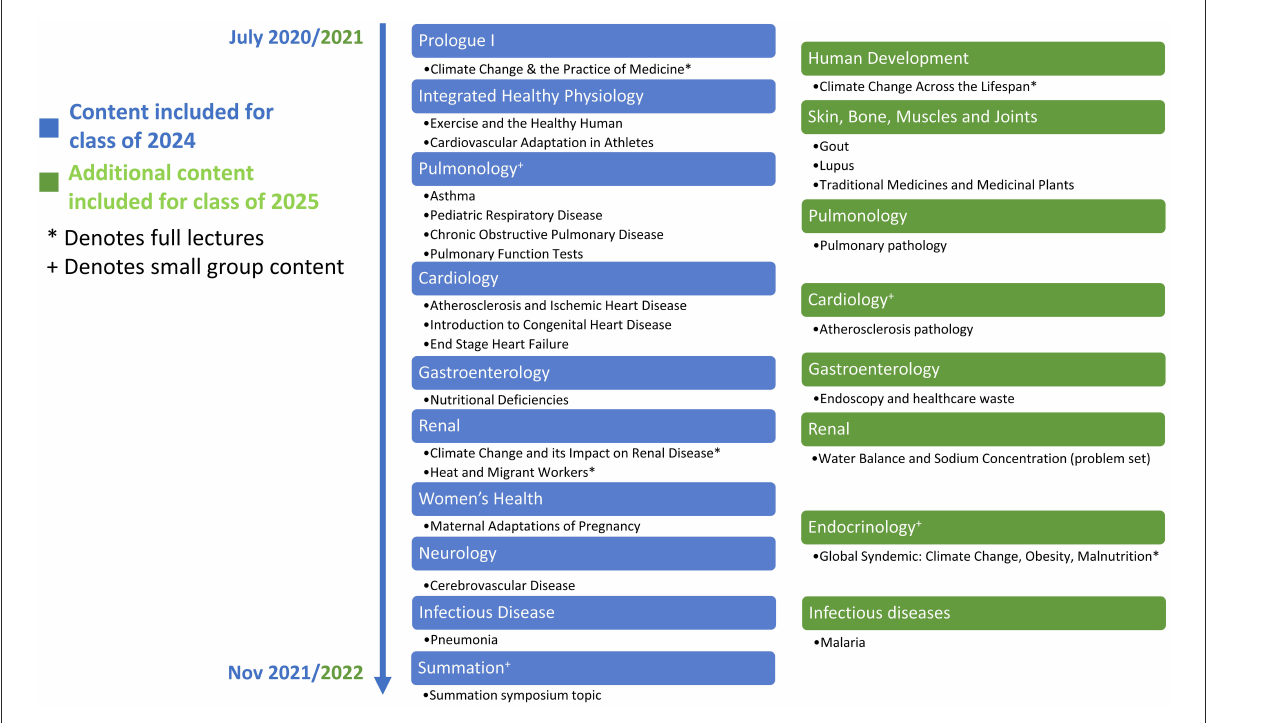
FIGURE1 Climate change and environmental health content disseminated across pre-clinical courses and topics.